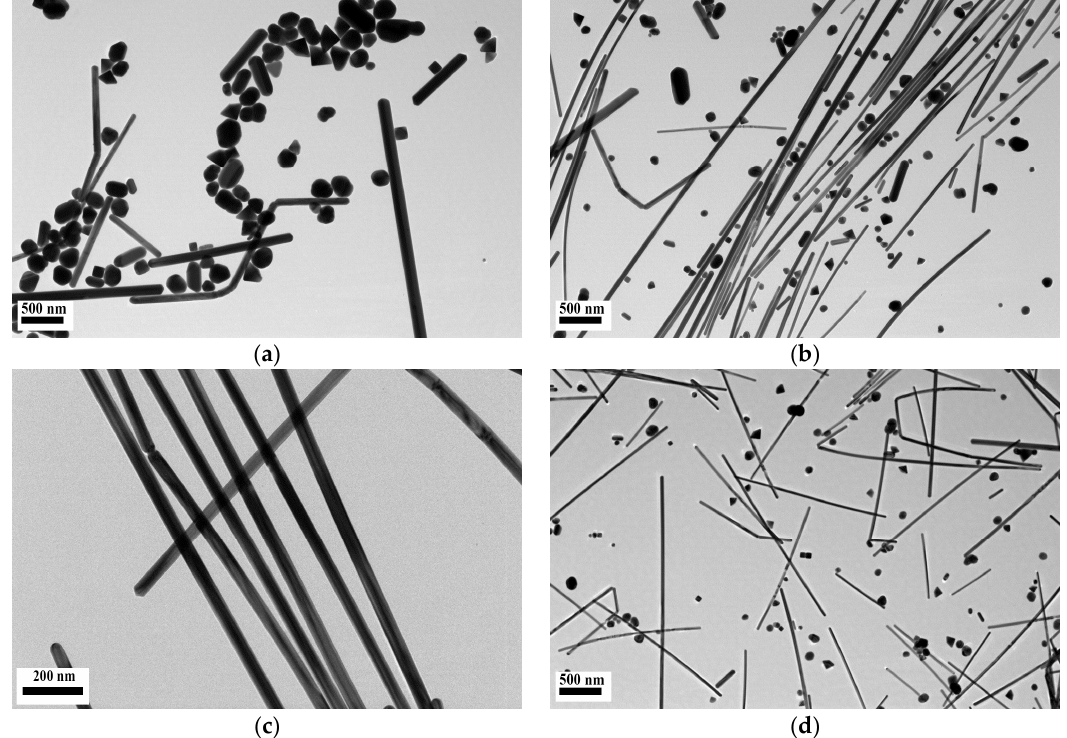
Figure 1. Transmission electron microscopy (TEM) images of Ag nanomaterials obtained through the use of different molar ratios of poly(vinyl pyrrolidone) (PVP) to silver nitrate (AgNO 3 ): ( a ) 0.5:1, ( b ) 3:1, ( c ) 5.5:1, ( d ) 8:1.